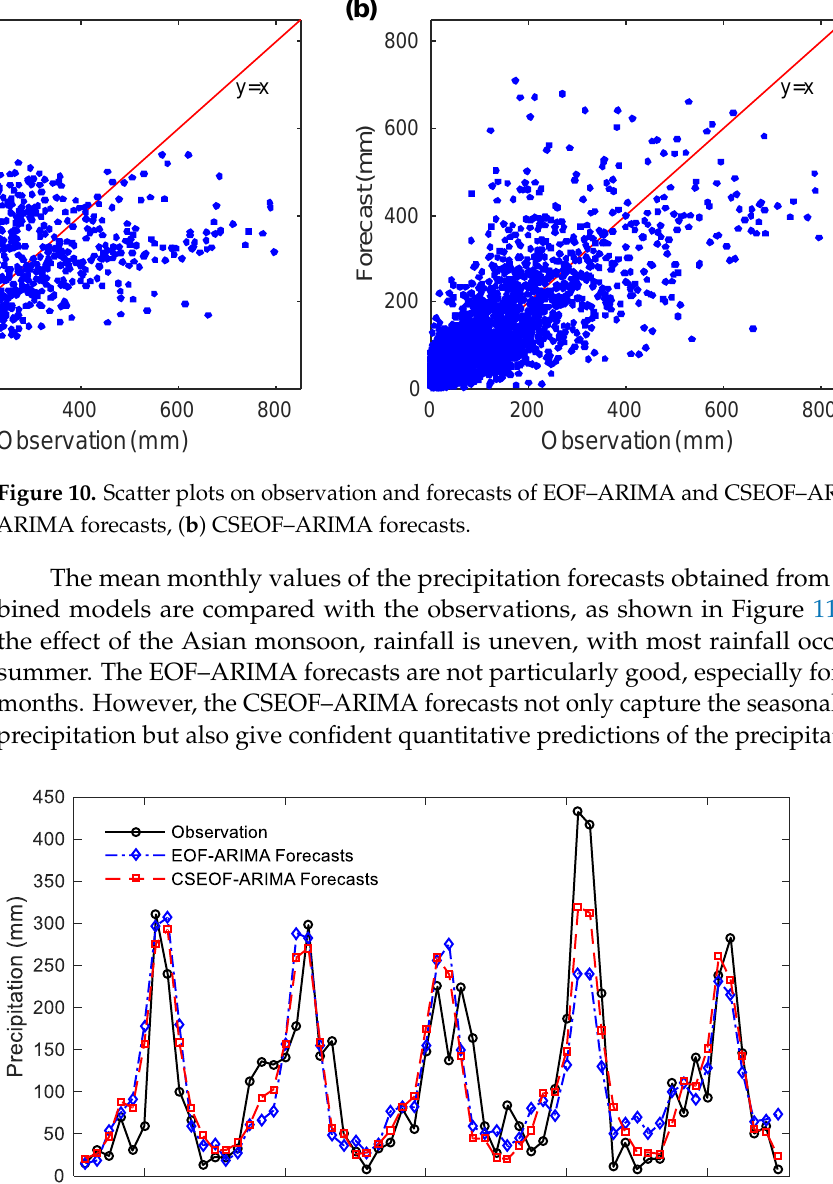
Figure 11. Temporal mean of observation with EOF – ARIMA and CSEOF – ARIMA forecasts.